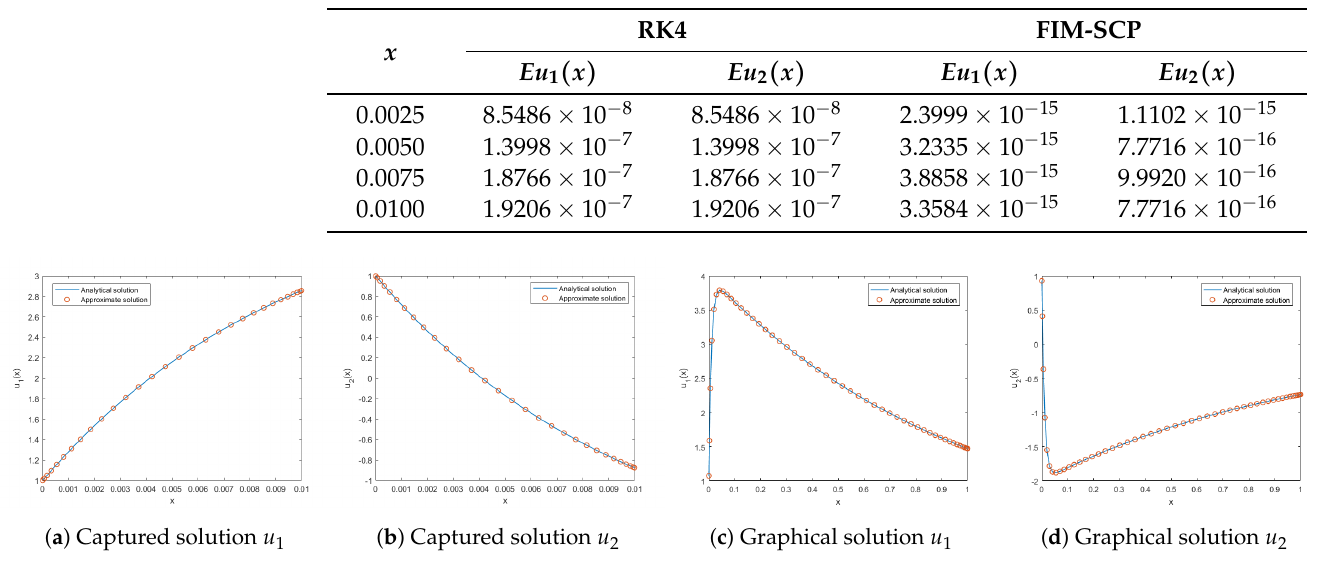
Table 10. Absolute errors of u 1 ( x ) and u 2 ( x ) at different x close to zero for Example 6.